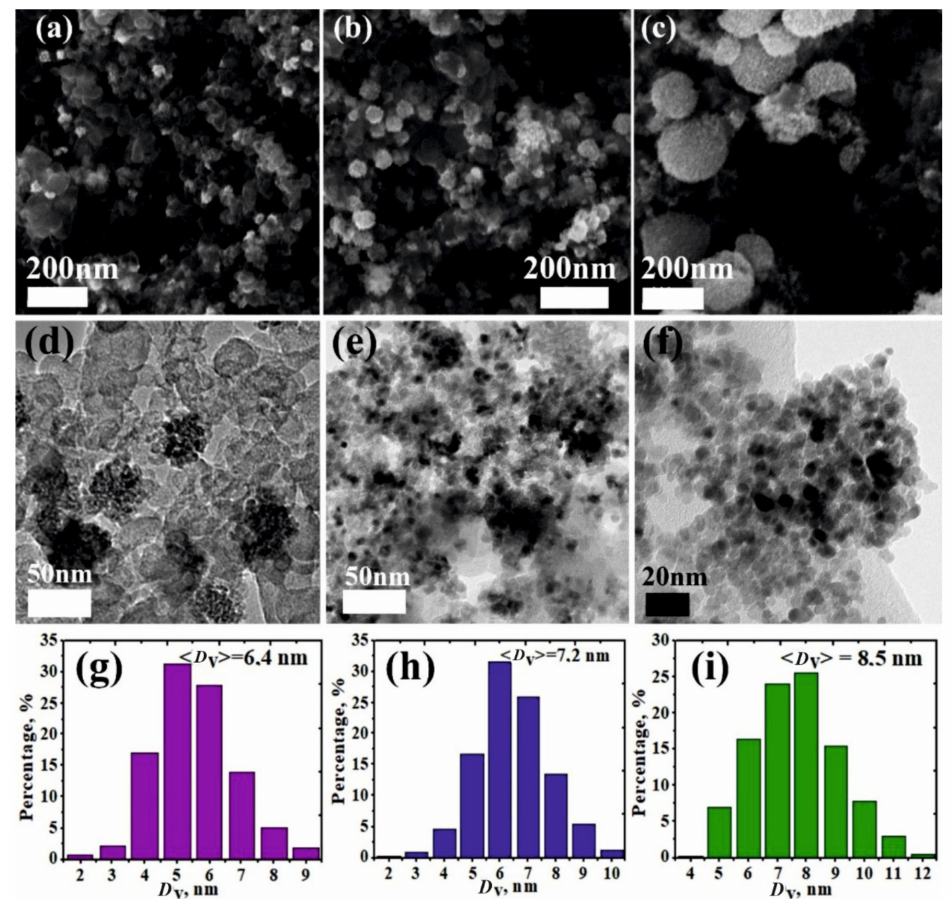
Figure 3. SEM ( a – c ) and TEM ( d – f ) images and grain size distributions ( g – i ) of NiO nanoparti- cles in NiO/C nanocomposites with different NiO concentrations: ( a , d , g ) 10 wt%, ( b , e , h ) 50 wt%, ( c , f , i ) 90